Question: Write a descriptive caption for this figure.
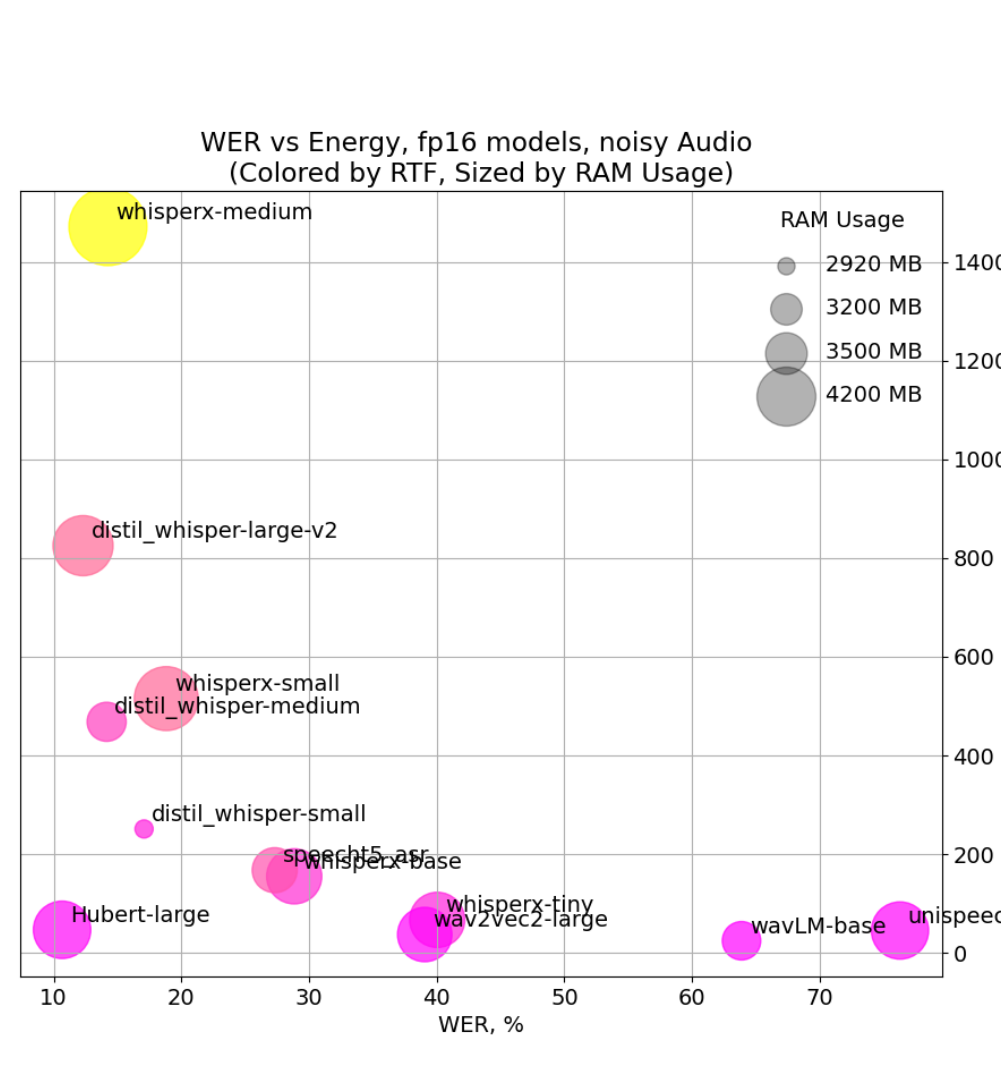
Answer: Scatterplot of word error rate and energy consumption for noisy audio.